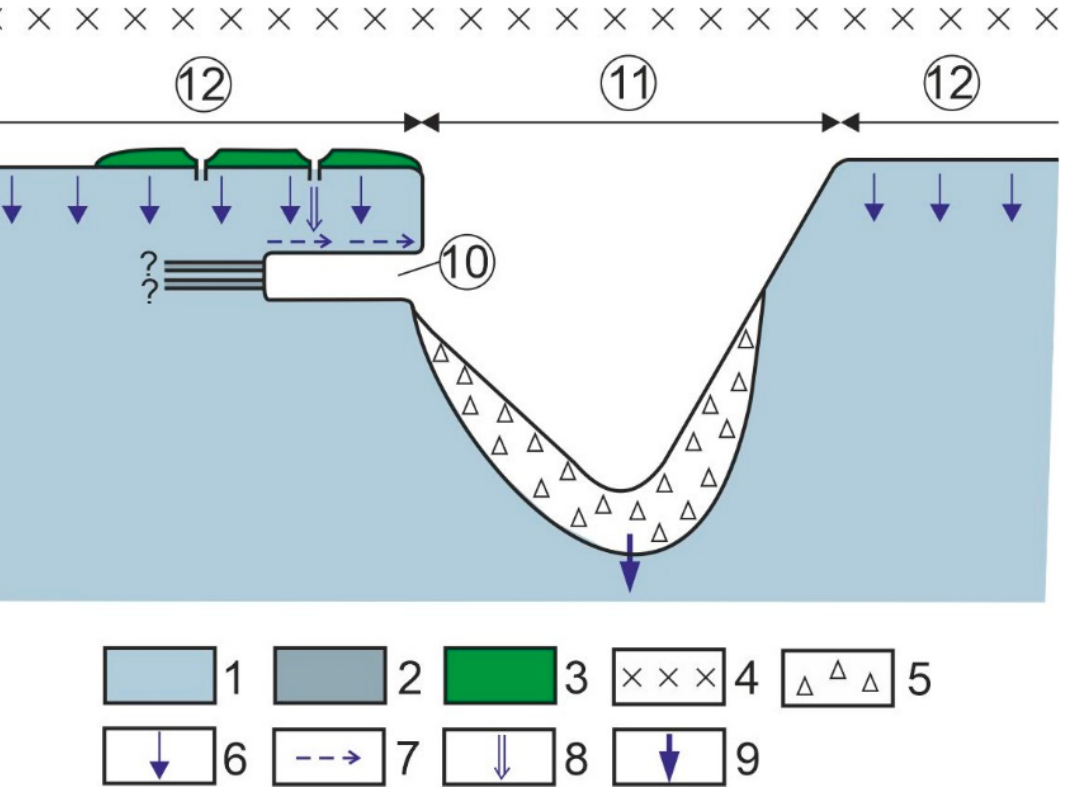
Figure 15. Incomplete epigene karst system in mature phase in cross-section. Legend: 1. Limestone, 2. Impermeable intercalation (silica), 3. Permeable cover, 4. Former surface of the cover that denuded by present, 5. Slope debris, 6. Areal diffuse infiltration, 7. Former water motion above impermeable intercalation, 8. Local water inflow, 9. Linear seepage, 10. Cave-in, 11. Epigenetic valley, 12. Block roof.